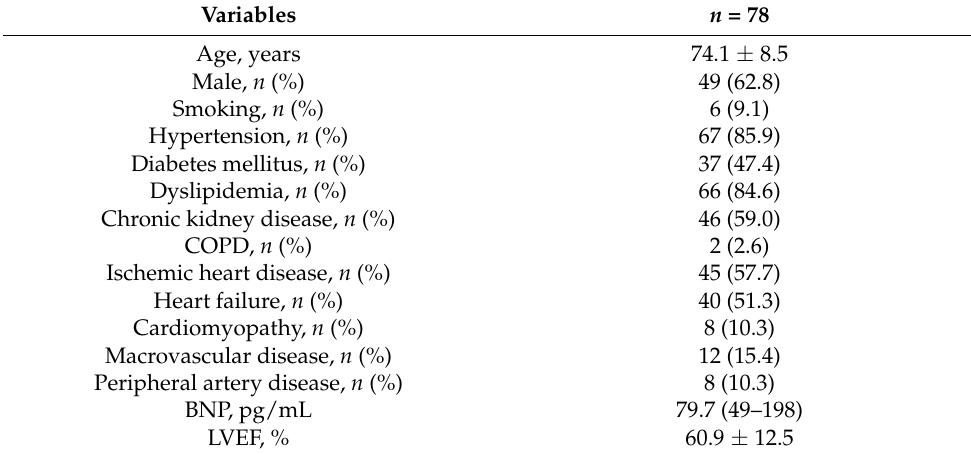
Table 1. Patient characteristics before restart CR.